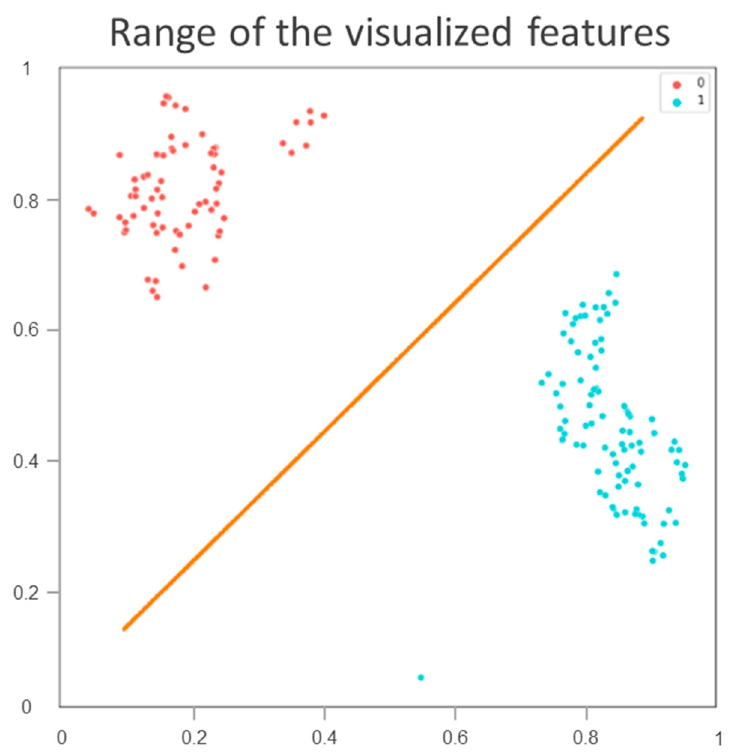
Figure 4. Classification performance of training cohort by support vector machine for tumor regres- sion grade 3 or 4 responses following dimensionality reduction of visualized features. Blue spots represent tumor regression grade 3 or 4 responses; red spots correspond to responses lower than grade 3.